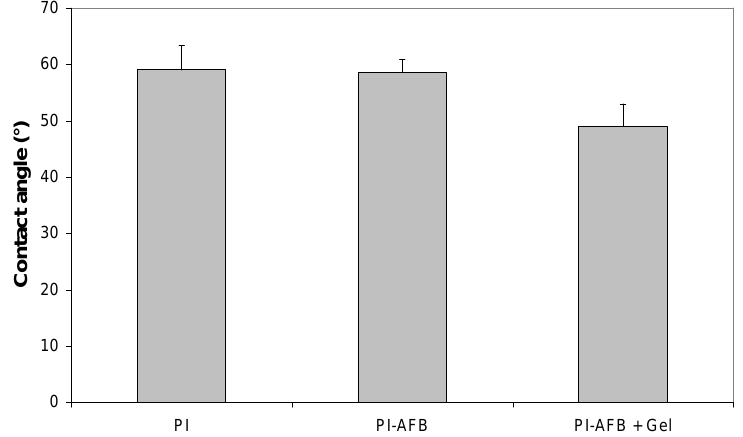
Figure 2. Static contact angle measurements of blank (PI), ester-modified (PI-AFB) and gelatin-coated PI (PI-AFB + Gel). The values obtained are an average of three separate measurements.